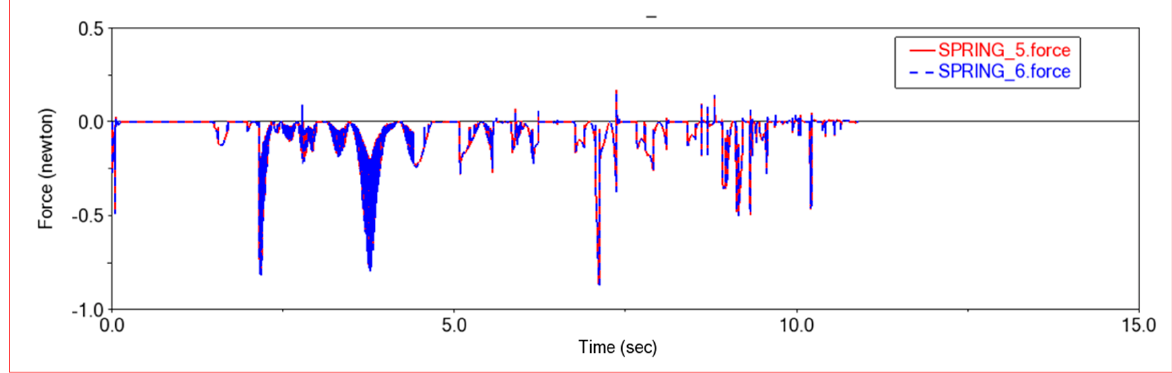
Figure 11. Force diagram of front frame shock absorber. SPRING-5-Front frame left shock absorber; SPRING-6-Front frame right shock absorber.